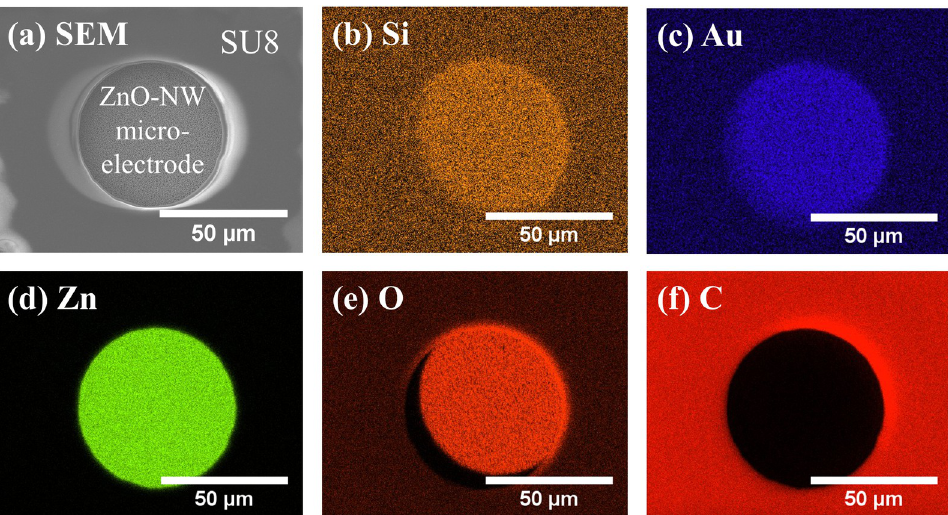
Fig 5. SEM image and energy-dispersive X-ray spectroscopy (EDS) mapping of a ZnO NW microelectrode. (a) SEM image of the ZnO NW microelectrode enclosed with a SU8 passivation layer. (b)–(f) EDS mapping of the ZnO NW microelectrode shown in (a). The EDS mapping shows (b) silicon (Si) of the Si/SiO 2 substrate; (c) gold (Au) of the underlying Cr/Au microelectrode; (d) zinc (Zn) of ZnO nanowires; (e) oxygen (O) of ZnO nanowires and the Si/SiO 2 substrate; and (f) carbon (C) of the SU8 passivation